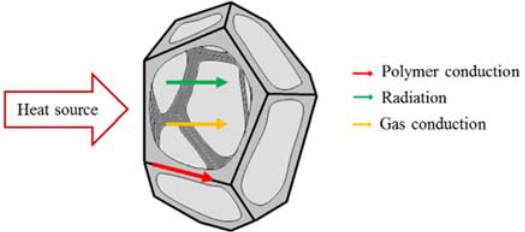
Figure 4. Representation of heat transfer mechanism in polymeric foams (adapted from